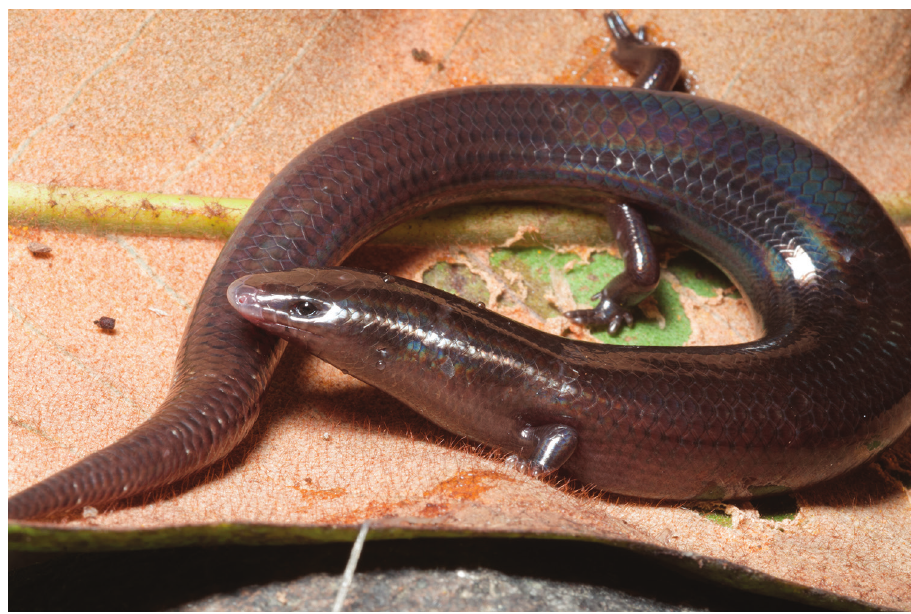
Figure 51. Brachymeles hilong male (KU 334282) photographed at the type locality, Mt. Hilong-hilong. This specimen was collected at Municipality of Remedios T. Romualdez, Agusan del Norte. Photo: